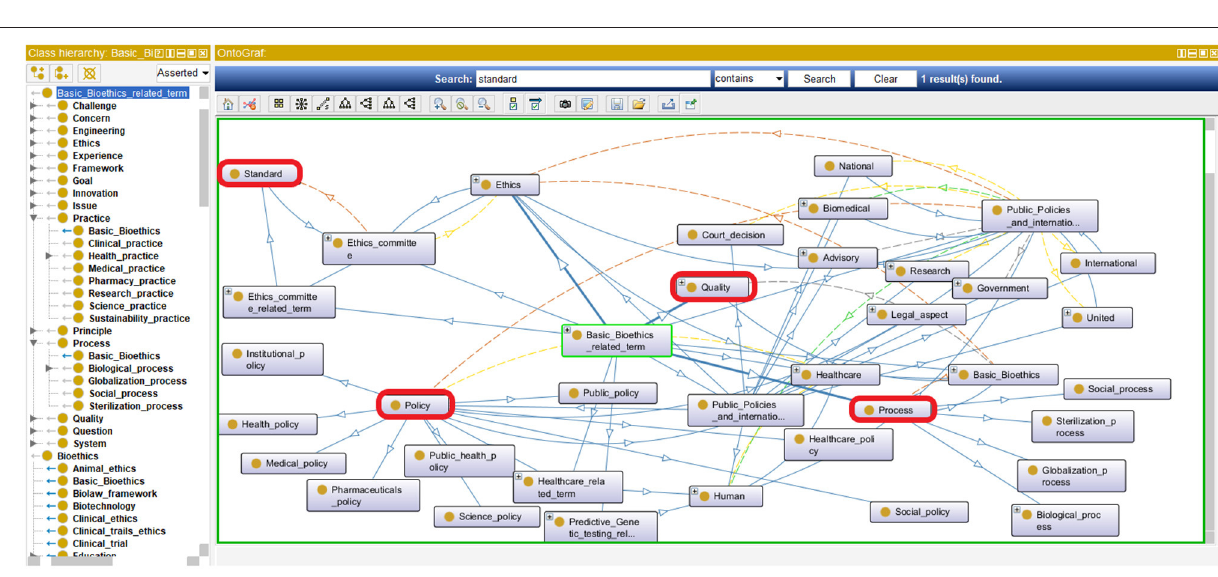
FIGURE 10 | A Representation of the main governance quality attributes in the iOntoBioethics